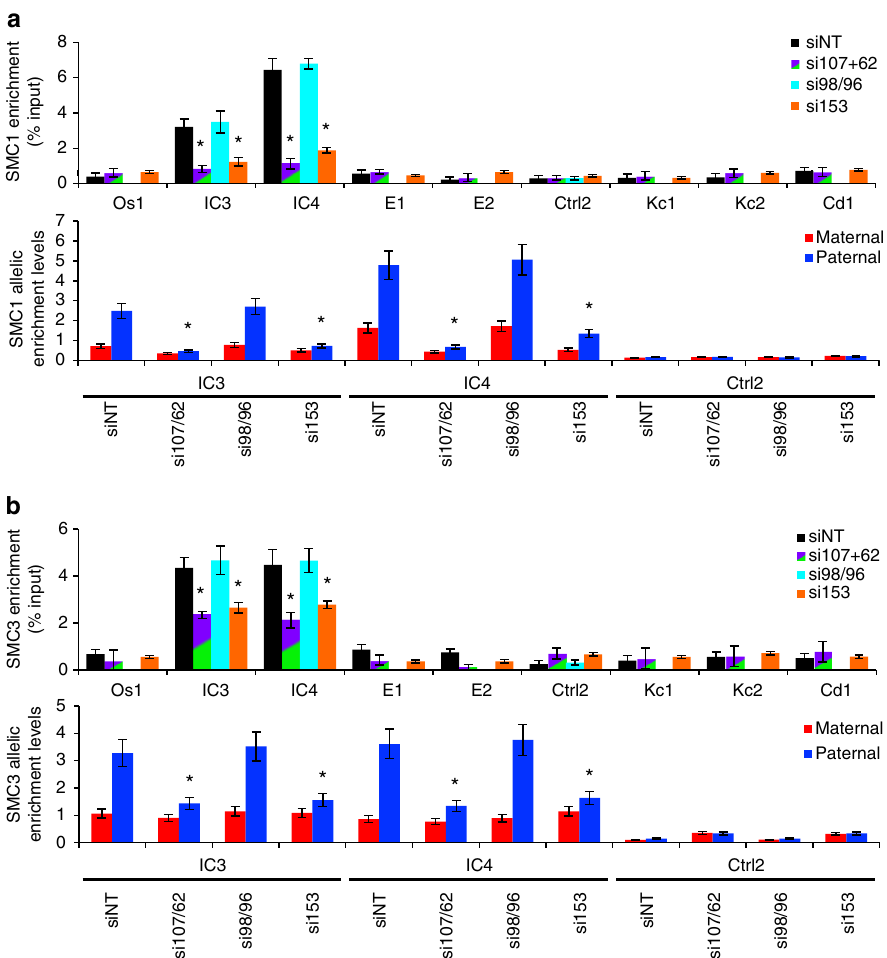
Fig. 7 SMC1A and SMC3 enrichment at the paternal Kcnq1ot1 ICR reduced upon nucleoporin depletion. Quantitative ChIP analysis and allelic analysis for a SMC1A and b SMC3 at positive mAb414 and NUP153 enrichment sites in control and Nup107 / Nup62 -double, Nup98/96 - (IC3, IC4 only) and Nup153 - depleted XEN cells ( n = 3 biological samples with three technical replicates per sample). Allelic proportions are represented as a percent of the total enrichment level. Error bars, s.e.m.; *, signi fi cance p < 0.05 compared to the siNT control ( t